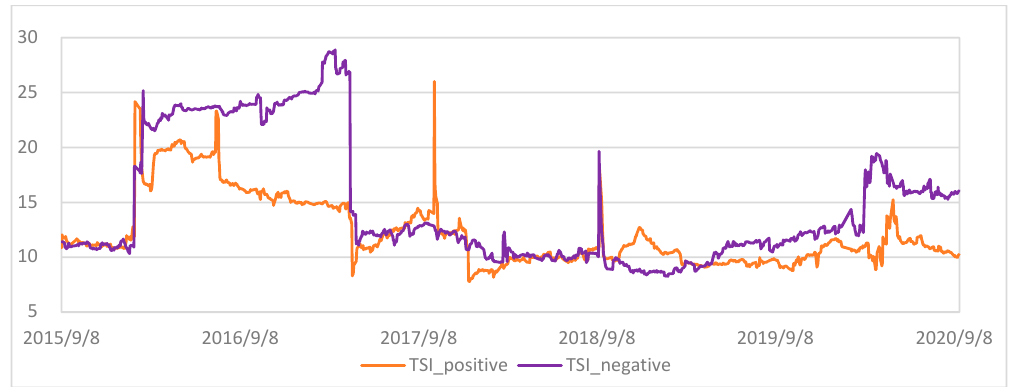
Figure 6. Dynamic total spillover indexes under the positive return system and negative return system.